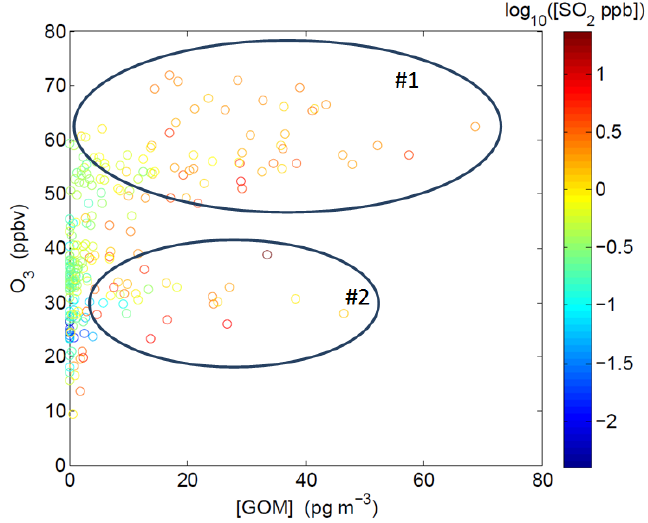
Figure 5. Hourly averaged ozone versus GOM color-coded with log daytime in the spring 2011